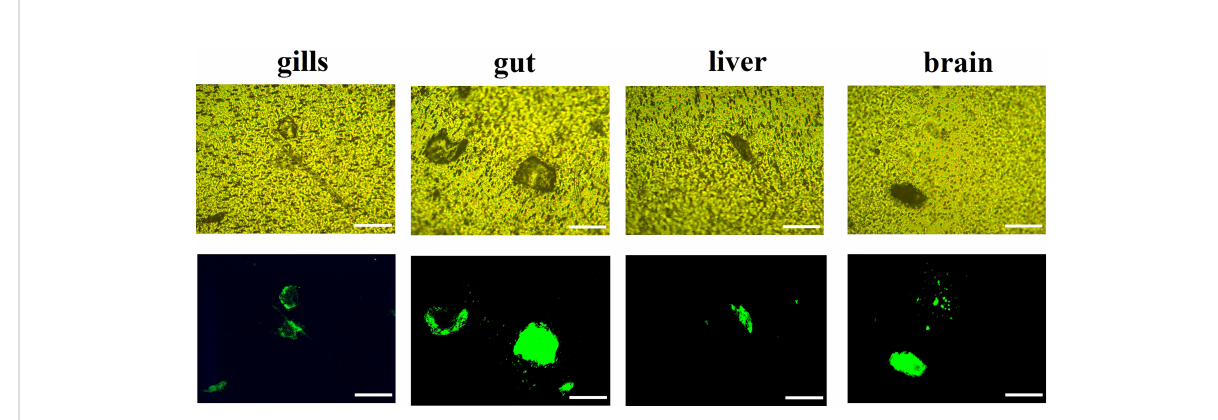
FIGURE 3 Representative fl uorescence iamges of MPs in fi sh tissues (gills,gut,liver and brain) after 20-day exposure of MPs alone. Fluorescene images of MPs in bright fi eld (up) and in green fl uorescene (down). Scale bar=